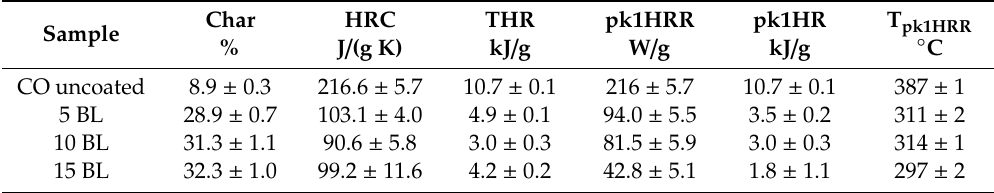
Figure 3. Microscale combustion calorimetry (MCC) measurements of coated and uncoated cotton fabrics, measured under nitrogen with 1 K/s heating rate. Table 3. Microscale combustion calorimetry measurement data.